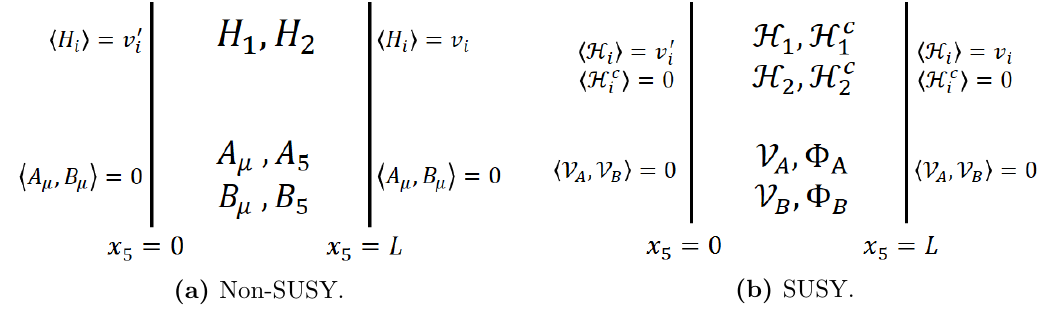
Figure 2 . Bi-axion in(cid:13)ation (cid:12)eld content: (a) non-SUSY and (b) SUSY version. See text for